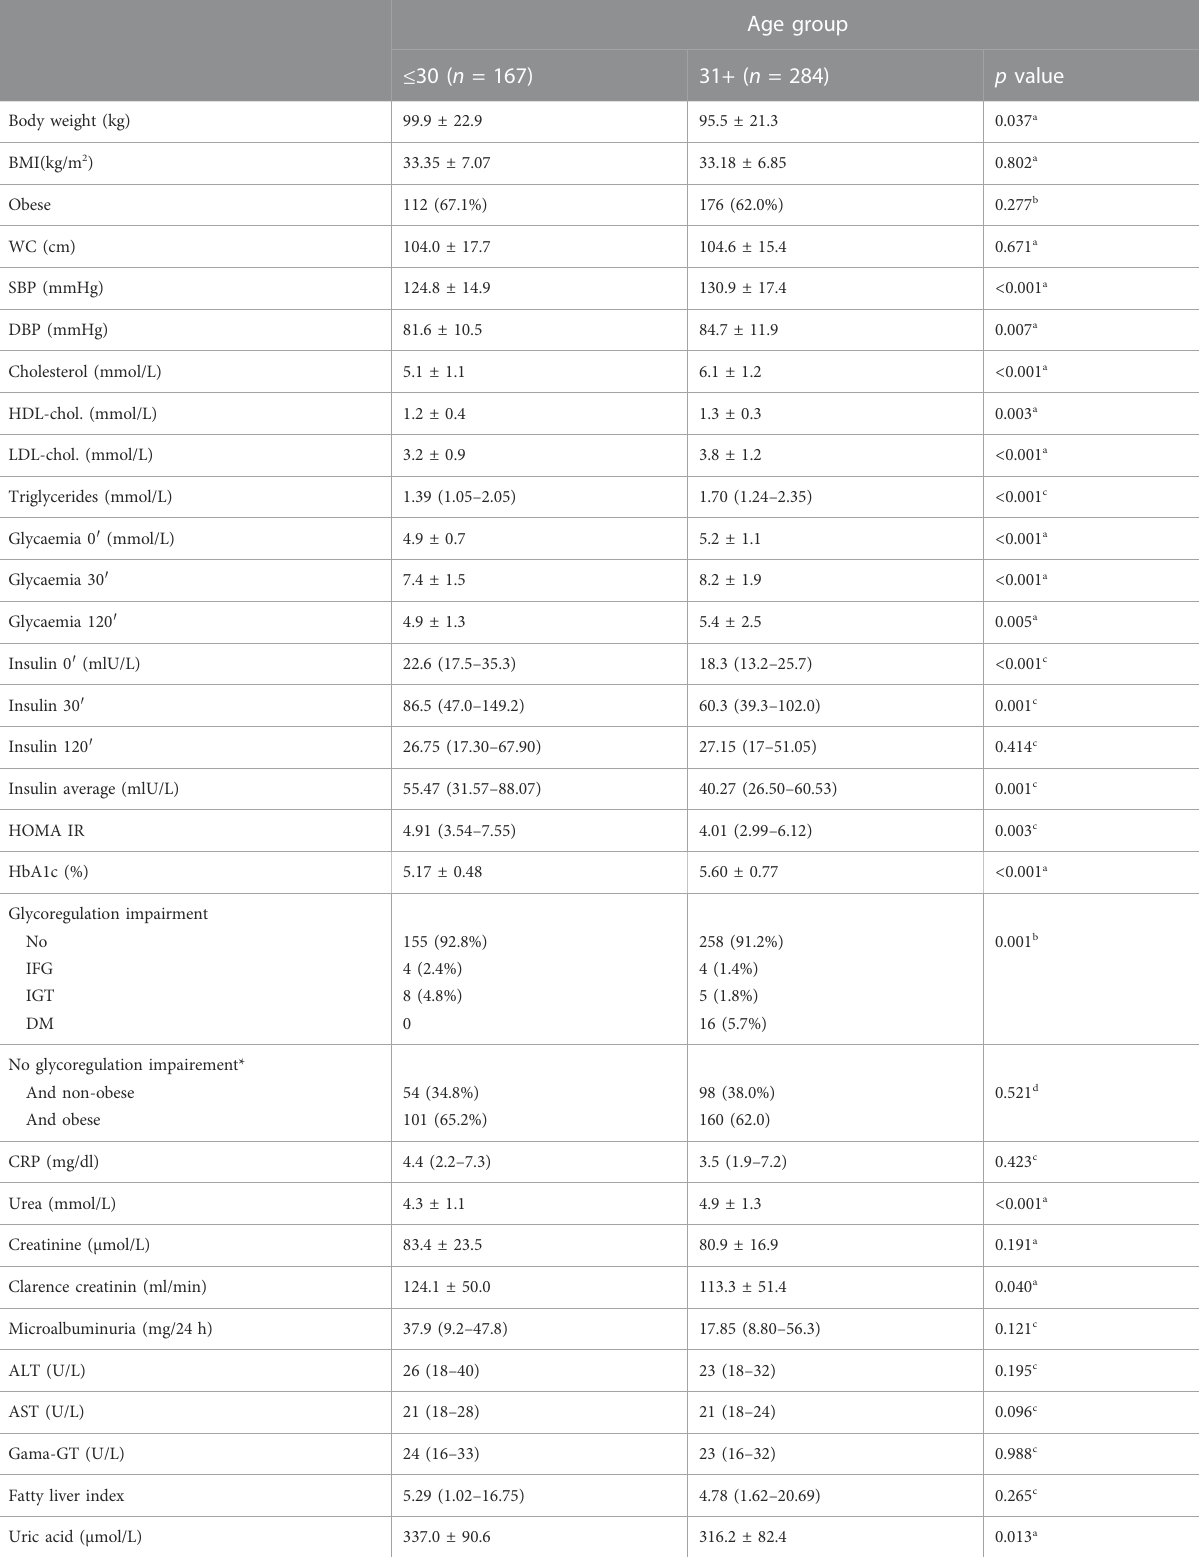
TABLE 1 Anthropometrical and biochemical parameters - age group